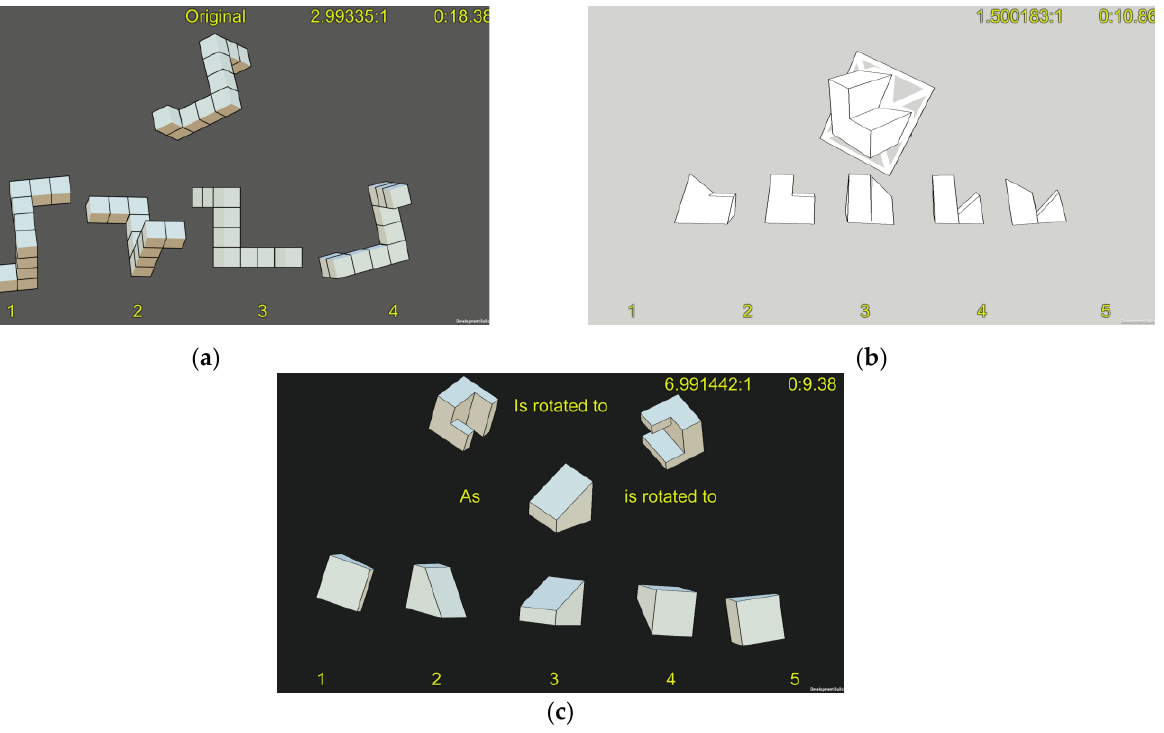
Figure 1. The various test types: ( a ) MRT test with an orthographic camera, 3:1 contrast ratio, no rotation, and shadows turned on; ( b ) MCT test with a perspective camera, 60 ◦ FoV, 1.5:1 contrast ratio, no rotation, and shadows turned off; ( c ) PSVT test with an orthographic camera, 7:1 contrast ratio, 15 ◦ camera rotation, and shadows turned